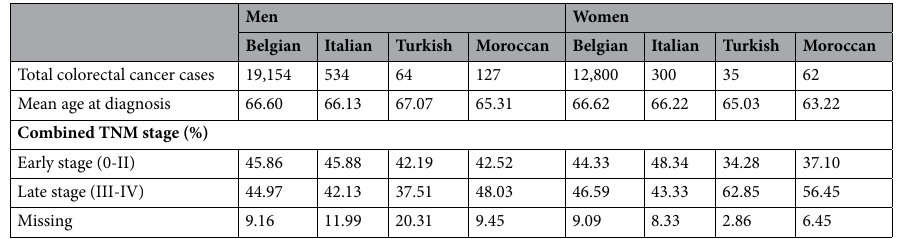
Table 2. Description of colorectal cancer cases among the study population aged 50 to 74 years, by gender and migrant origin, Belgium,